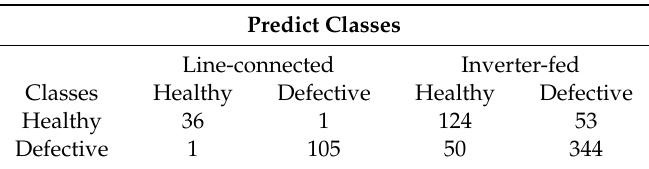
Table 4. Confusion